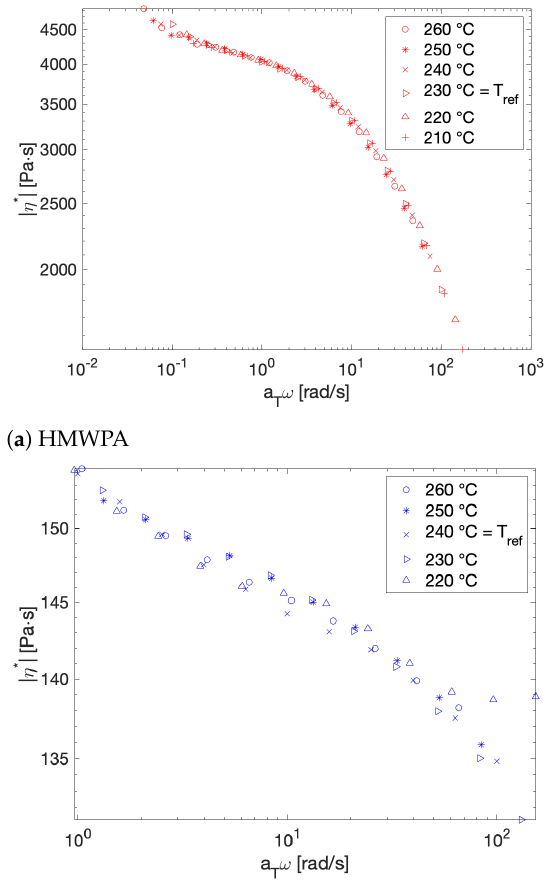
Figure A4. The master curves obtained by applying time-temperature superposition (TTS) on frequency sweep data from rheological measurements in the melt state for ( a ) HMWPA (T ref = 230 °C) and ( b ) LMWPA (T ref = 240